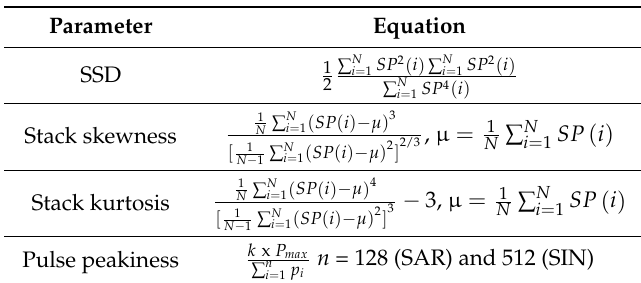
Table 2. The equations to retrieve Stack Standard Deviation (SSD), stack skewness and kurtosis, as well as Pulse Peakiness (PP)